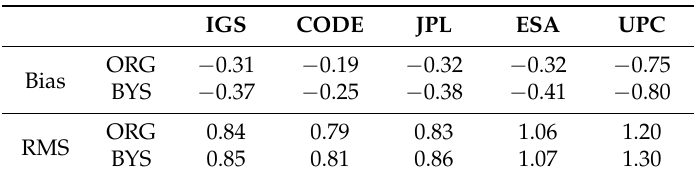
Table 4. Differences in receiver DCBs based on original LSE and Bayesian approaches compared with IAAC products (unit: TECU).